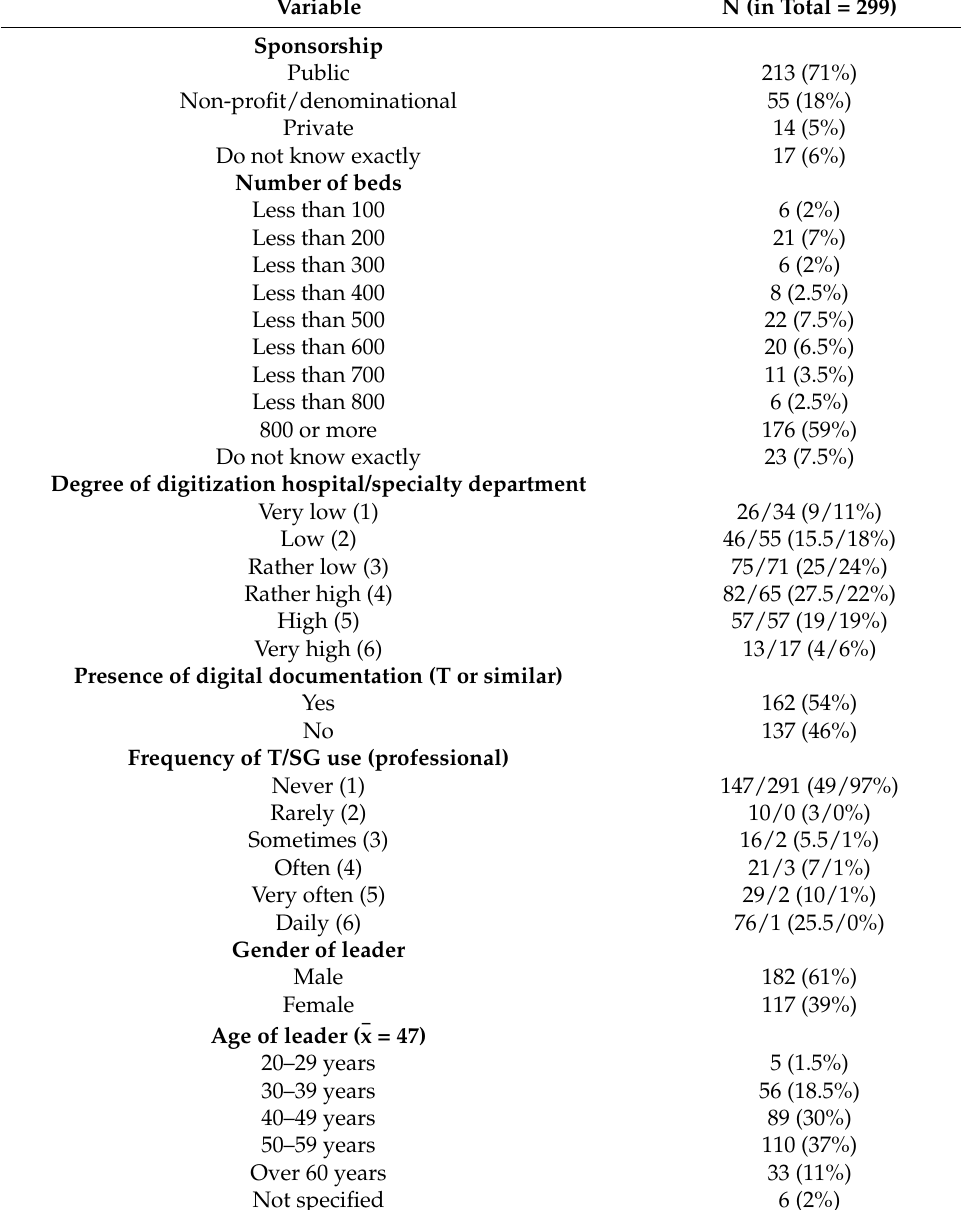
Table 2. Baseline characteristics of the respondents’